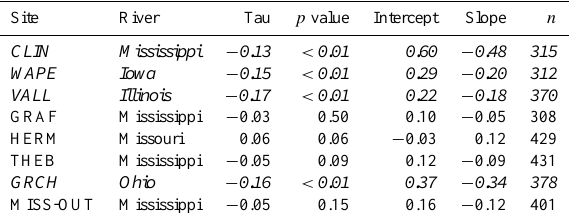
Table 3. Kendall’s tau and robust line results of nitrate anomaly and Qratio relationships, using all contemporaneous flow data. Statisti- cally significant relationships ( p < = 0.05) are italicized [ n , number of